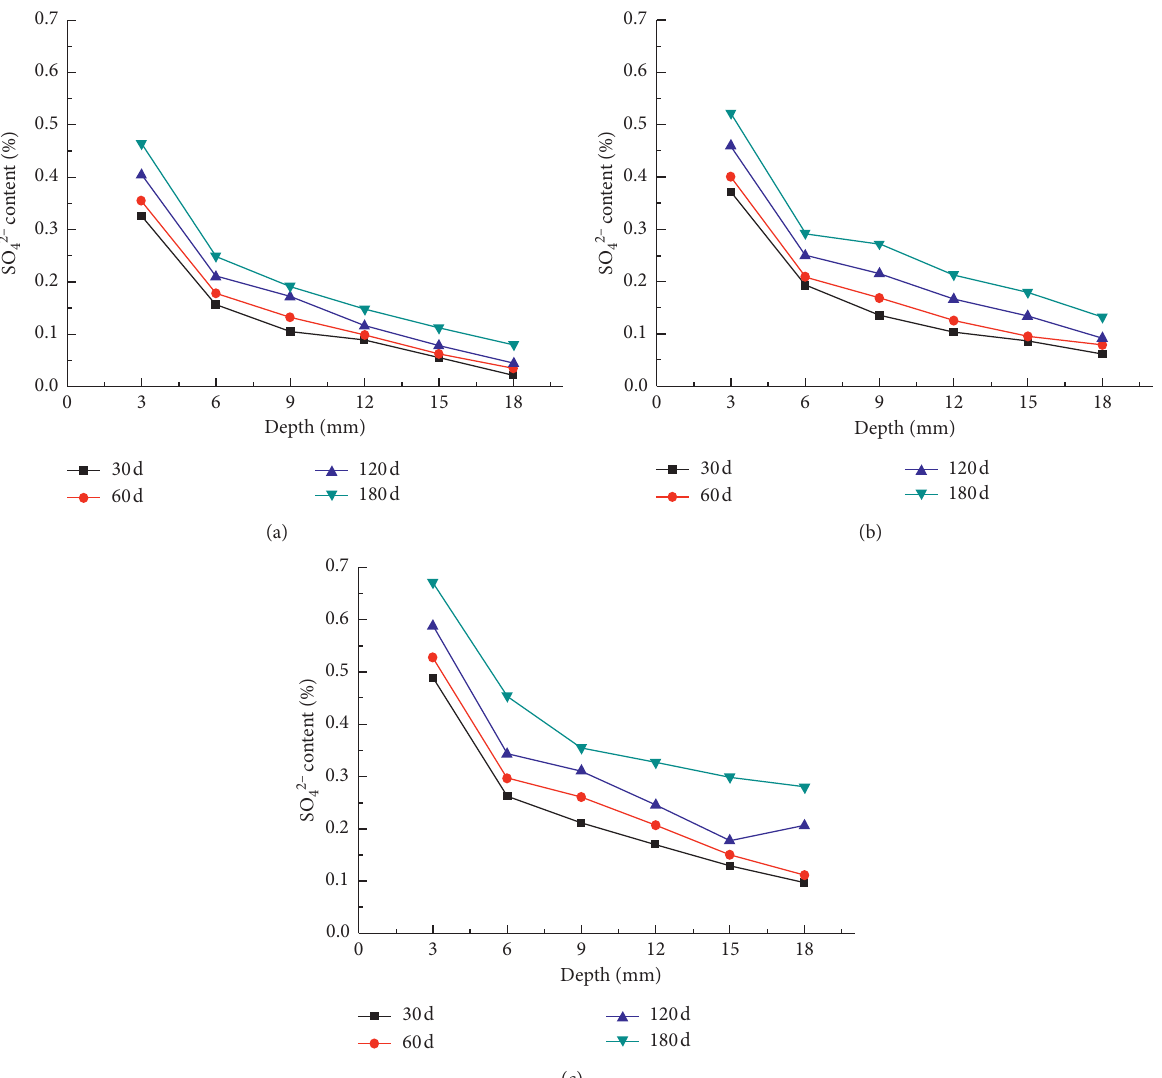
Figure 2: The relationship between SO 2 − concentration and immersion time at different diffusion depths. (a) 3% Na 2 SO 4 − , (b) 5% Na 2 SO 4 , 4 and (c) 10% Na 2 SO 4